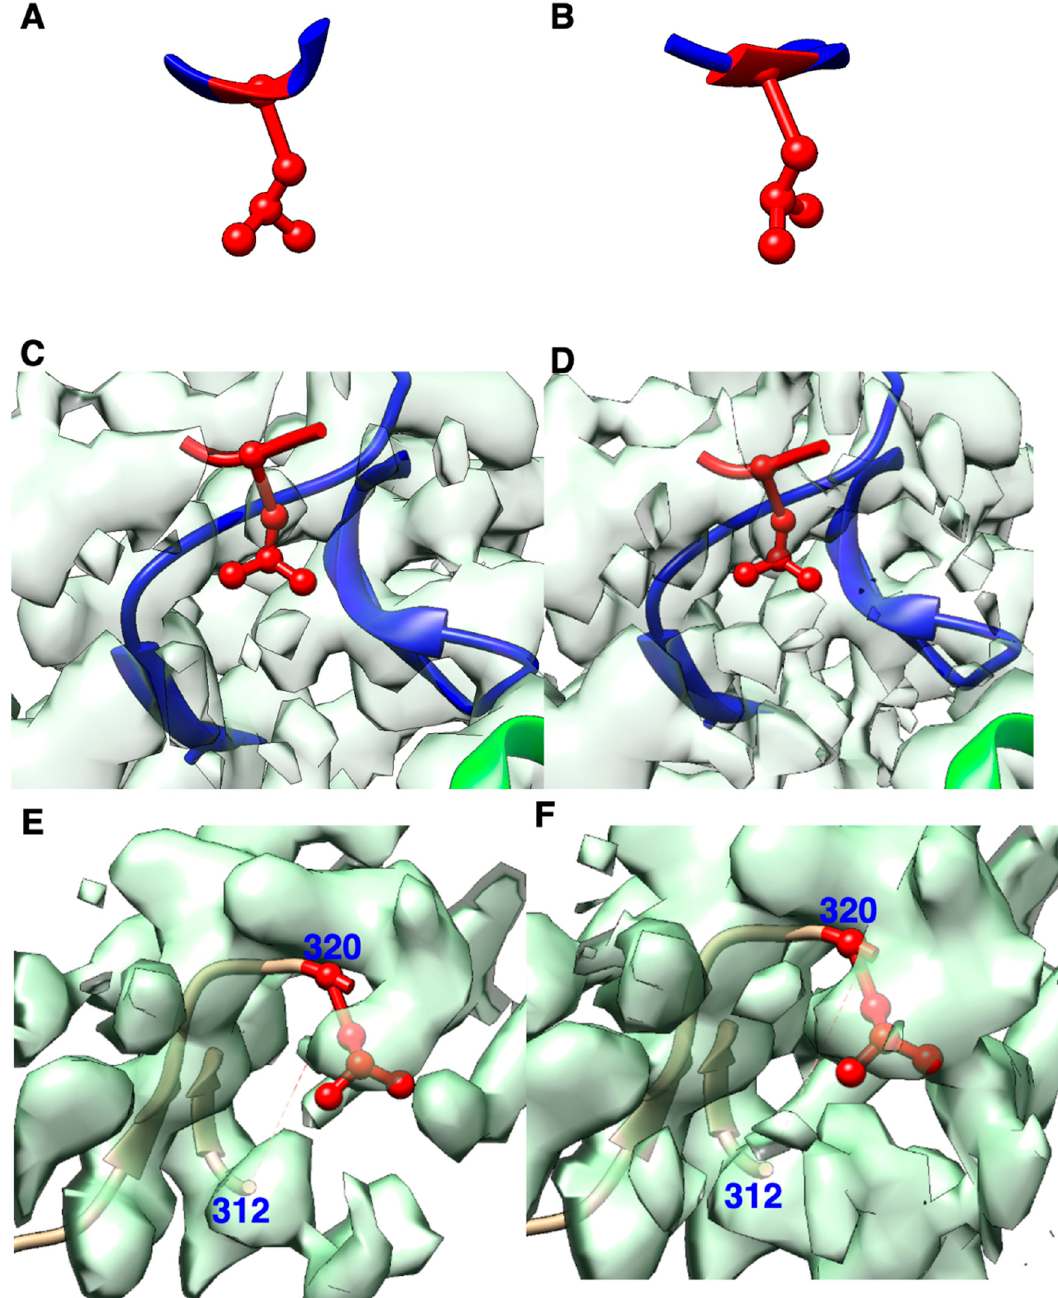
Figure 3. Four leucine (LEU) examples. ( A ) LEU with index 17 in chain A of protein 6g72 (PDB ID), not an HBOS outlier; ( B ) LEU with index 167 in chain L of protein 6j0n (PDB ID), an HBOS outlier with abnormally long sidechain length; ( C , D ) LEU with index 409 in chain X of protein 6j0n (PDB ID) superimposed on cryo-EM density maps using density threshold 0.1 in ( C ) and 0.07 in ( D ), an HBOS outlier having abnormally short sidechain length; ( E , F ) LEU with index 320 in chain A of protein 6fe8 (PDB ID) is superimposed on the cryo-EM density map using a threshold of 0.06 in ( E ) and 0.04 in ( F ), an HBOS outlier having abnormal backbone torsion angle. The segment from 313 to 319 is not available in the structure.